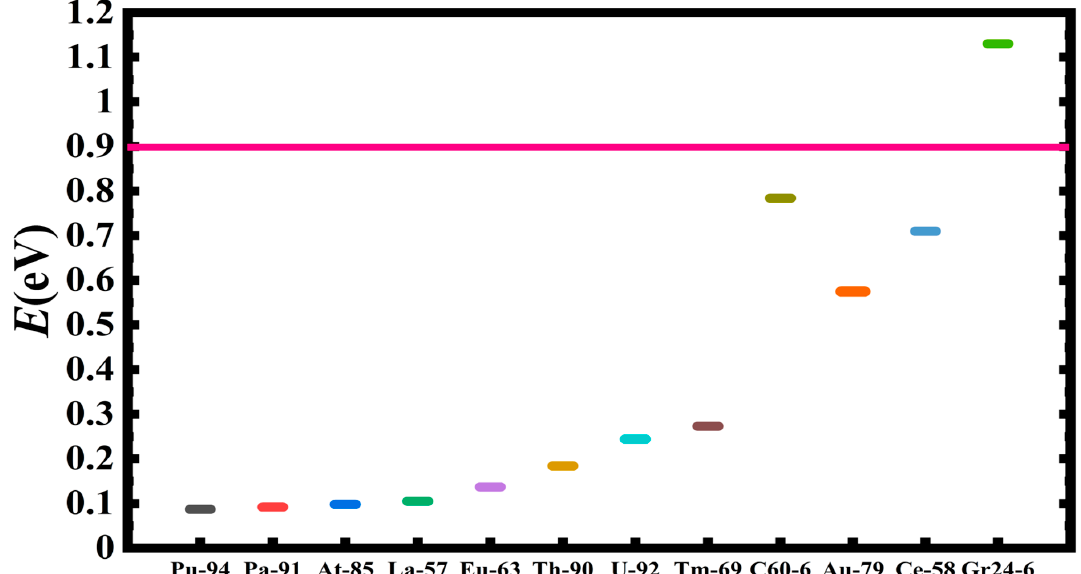
Figure 9. Transition state energy barrier reduction, E(eV), in ascending order of catalytic effectiveness for doubly-charged heavy systems, including C 60 and 24 carbon graphene (Gr24-6). The horizontal axis indicates the not-to-scale catalyzing systems, and the solid pink line represents the barrier energy position with no catalyst present.